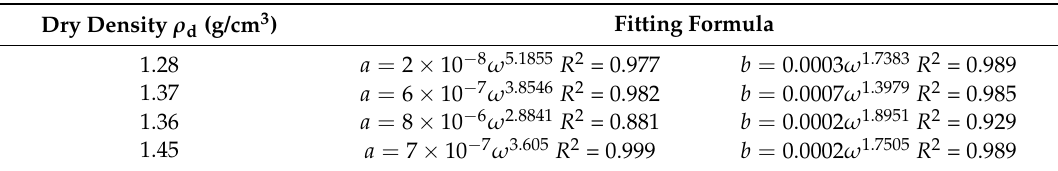
Table 4. Fitting formula of a and b .